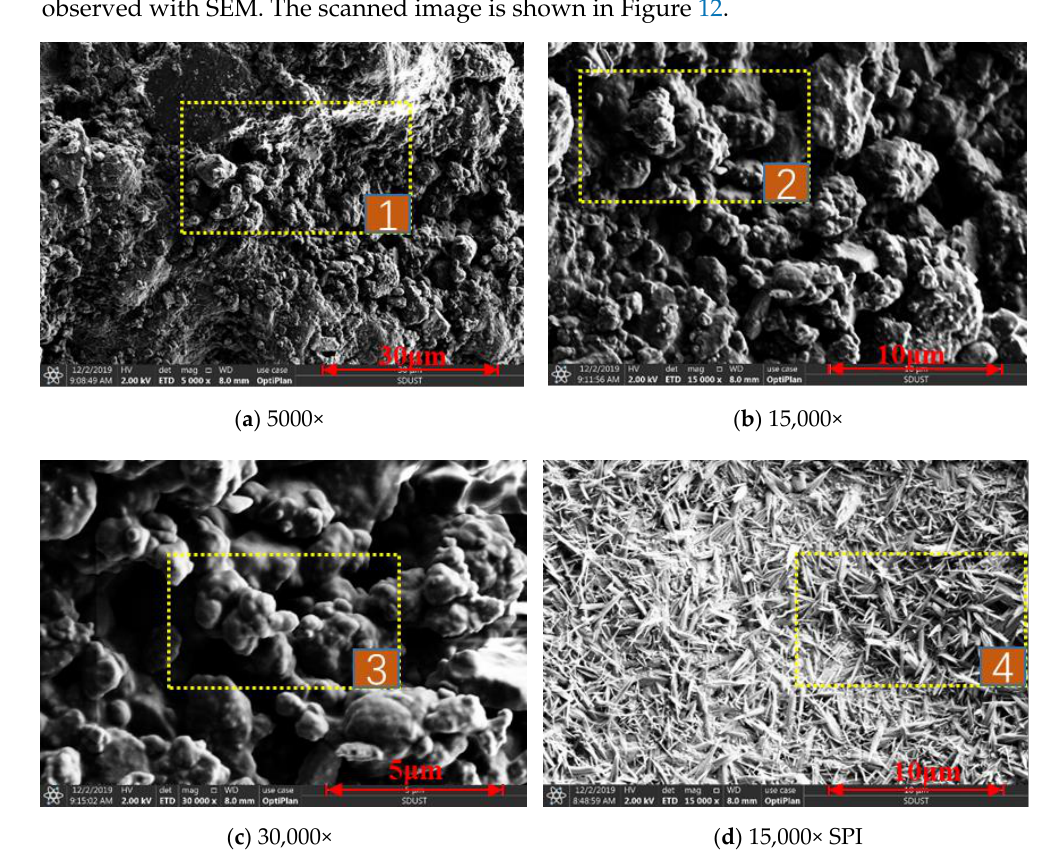
Figure 12. SEM images of dust suppressant and soy protein isolate. ( a – c ) are SEM images of 5000, 15,000, and 30,000 respectively enlarged by the dust suppressant sprayed on the surface of coal dust; ( d ) figure is an SEM image of dry CDS.